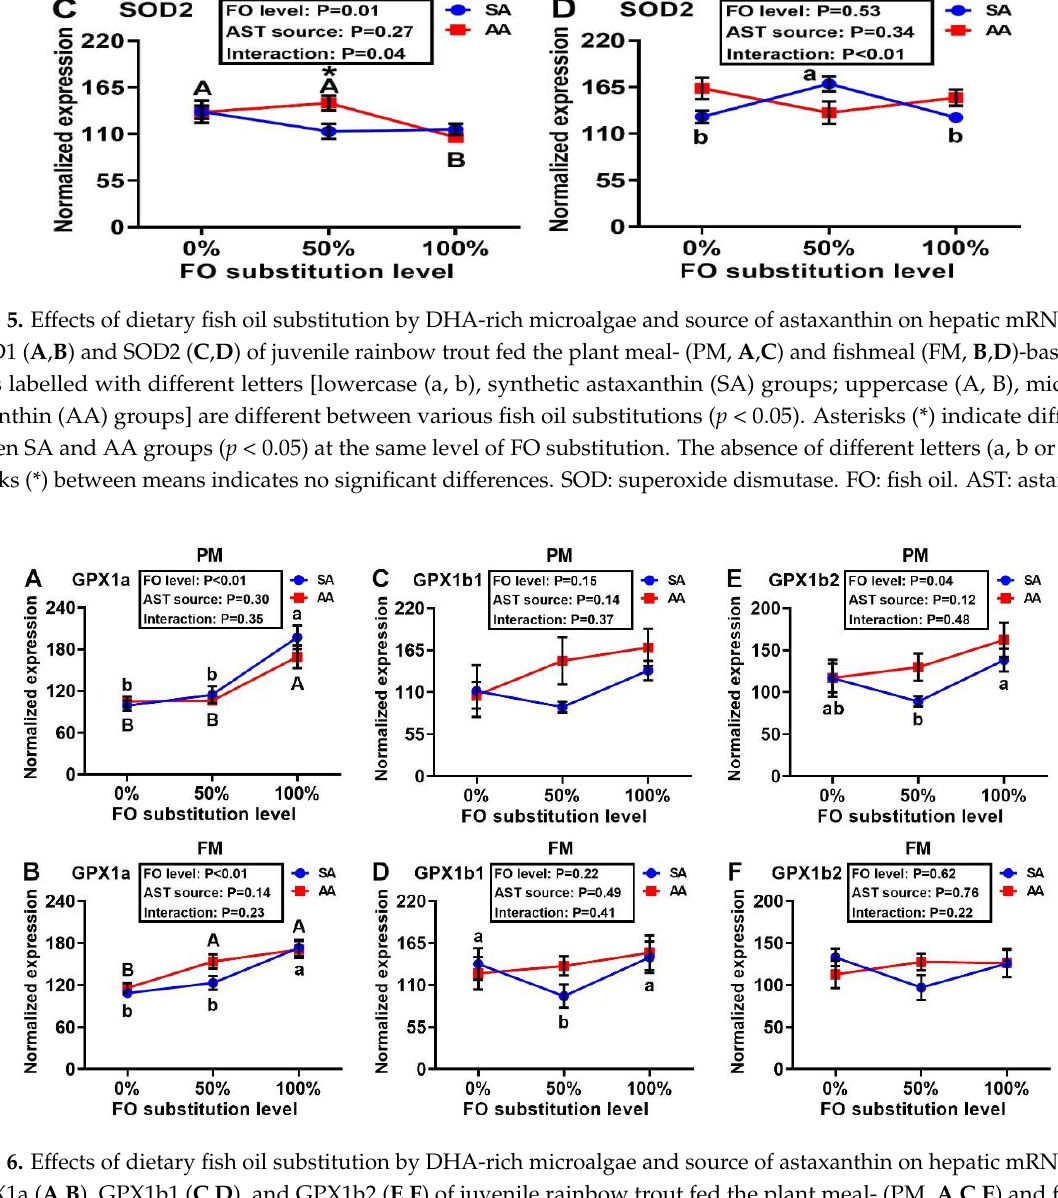
Figure 7. Effects of dietary fish oil substitution by DHA-rich microalgae and source of astaxanthin on hepatic mRNA levels of CAT ( A , B ), GR ( C , D ), and GST ( E , F ) of juvenile rainbow trout fed the plant meal- (PM, A , C , E ) and fishmeal (FM, B , D , F )- based diets. Means labelled with different letters [lowercase (a, b), synthetic astaxanthin (SA) groups; uppercase (A, B), microalgae astaxanthin (AA) groups] are different between various fish oil substitutions ( p < 0.05). The absence of different letters (a, b or A, B) between means indicates no significant differences. CAT: catalase; GR: glutathione reductase; GST: glutathione S-transferase. FO: fish oil. AST: astaxanthin.